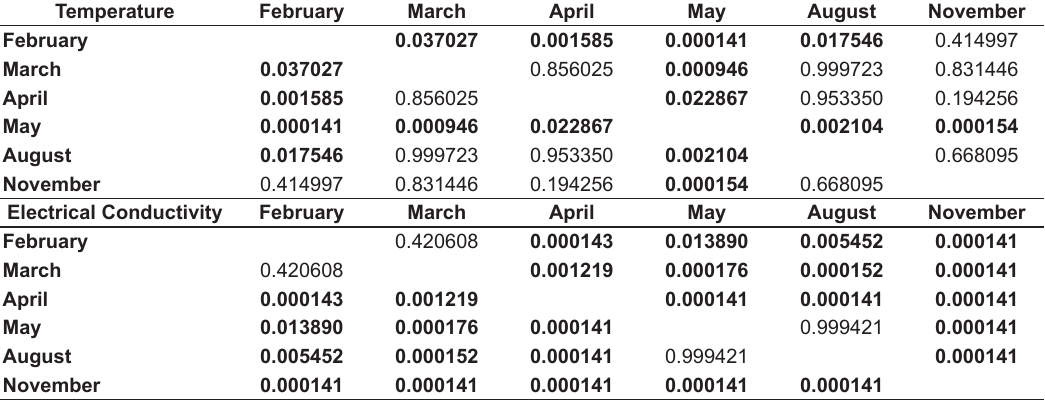
Table 4. Results for Tukey’s t-test: combinations of months for which significant differences in temperature, dissolved oxygen and conductivity were encountered in Lago